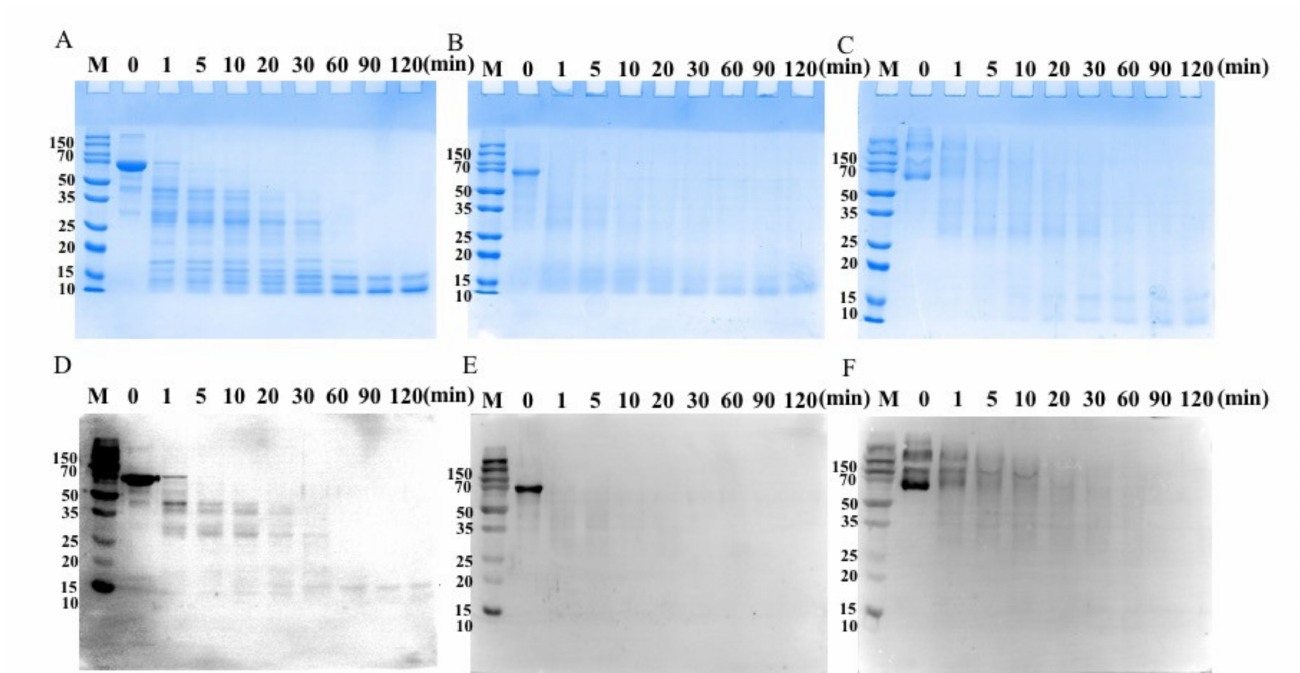
Figure 4. Effect of simulated gastric fluid digestion on the purified CA egg treated with 5 mmol/L AAPH and 1 mmol/L acrolein. Enzymatic digestion was performed, followed by SDS–PAGE. ( A ) Egg CA by pepsin; ( B ) AAPH-CA by pepsin; ( C ) acrolein-CA by pepsin. Enzymatic digestion was performed, followed by western blot analyses. ( D ) CA, ( E ) AAPH-CA, and ( F ) acrolein-CA were detected using pooled sera from patients allergic to egg with pepsin. In the controls (con), protease was replaced with 25 mmol/L PBS (pH 7.5). Molecular mass of protein markers (M) is shown (left side of each slide).